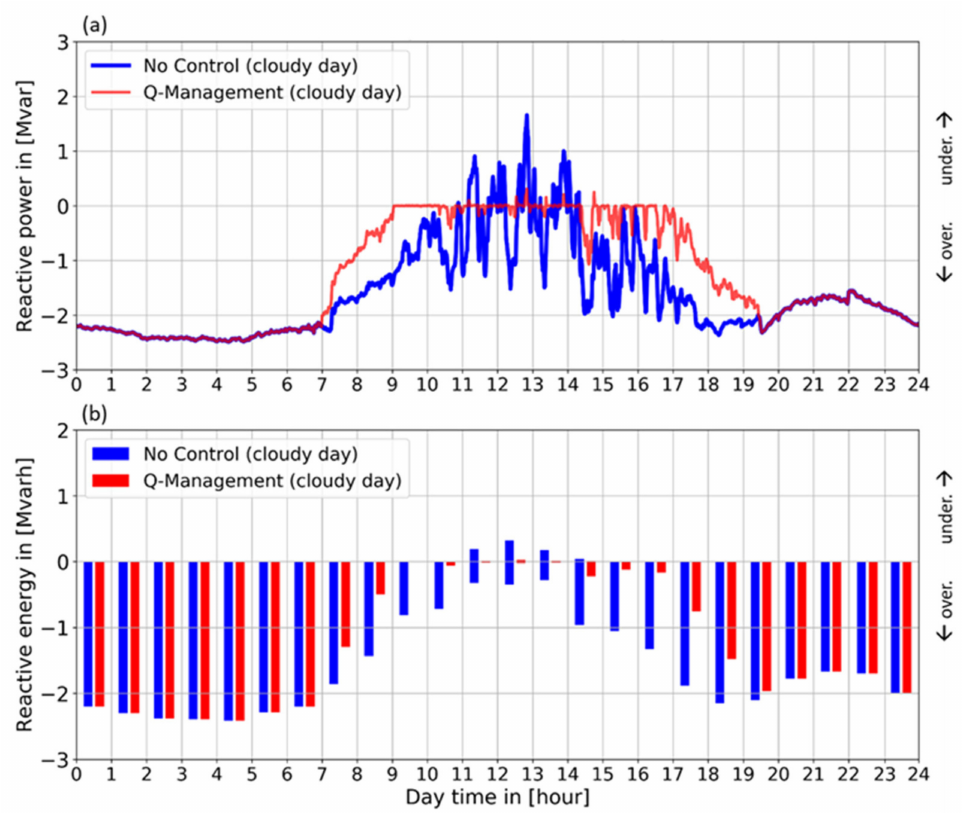
Figure 9. Reactive power exchange at 110 kV-NCP ( a ) and the resulting reactive energy exchange ( b ) for the investigated cloudy day (with 1 min control